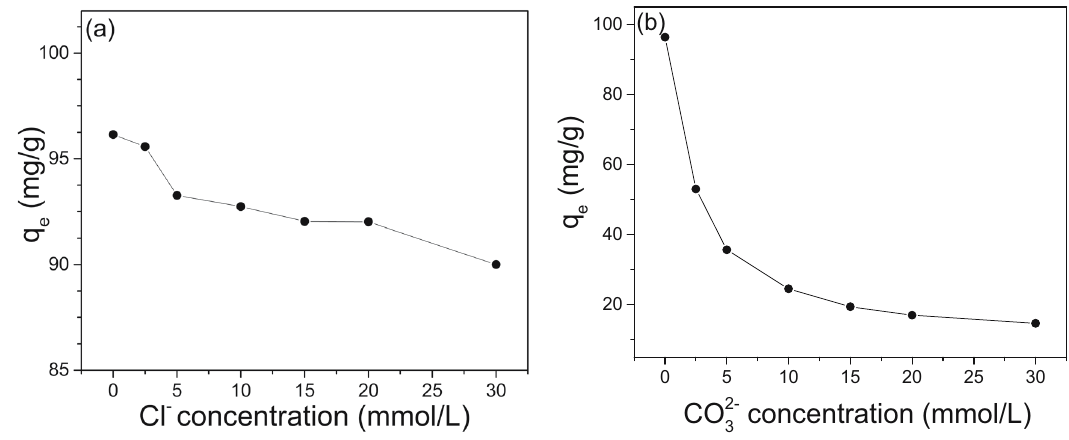
Figure 10: E ff ect of ( a ) Cl − and ( b ) CO 32− on the adsorption of SO 42− by the